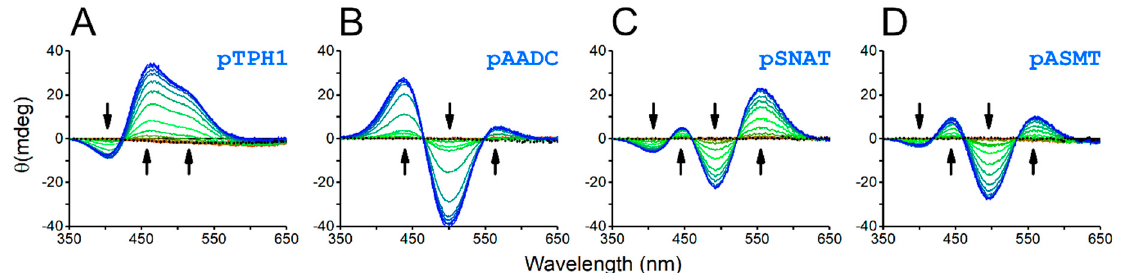
Figure 4. CD spectra of 0.95:1.00 mixtures of Ni(II) ions with the respective peptides, pTPH1 ( A ), pAADC ( B ), pSNAT ( C ), and pASMT ( D ), obtained for different pH values, starting from 3.5 (red) to 10.5 (blue). The spectra for apopeptides are represented by black dotted lines (near zero circular dichroism). The arrows mark the pH-dependent appearance of the d-d band characteristic for hydrolytic square planar 4N Ni(II) complexes. Table 1. Logarithmic protonation constants (log β ) a for peptides pTPH1, pAADC, pSNAT, and pASMT, and logarithmic stability constants (log β ) for their complexes with Ni(II) ions, determined at 25 ◦ C and I = 0.1M (KNO 3 ) b .